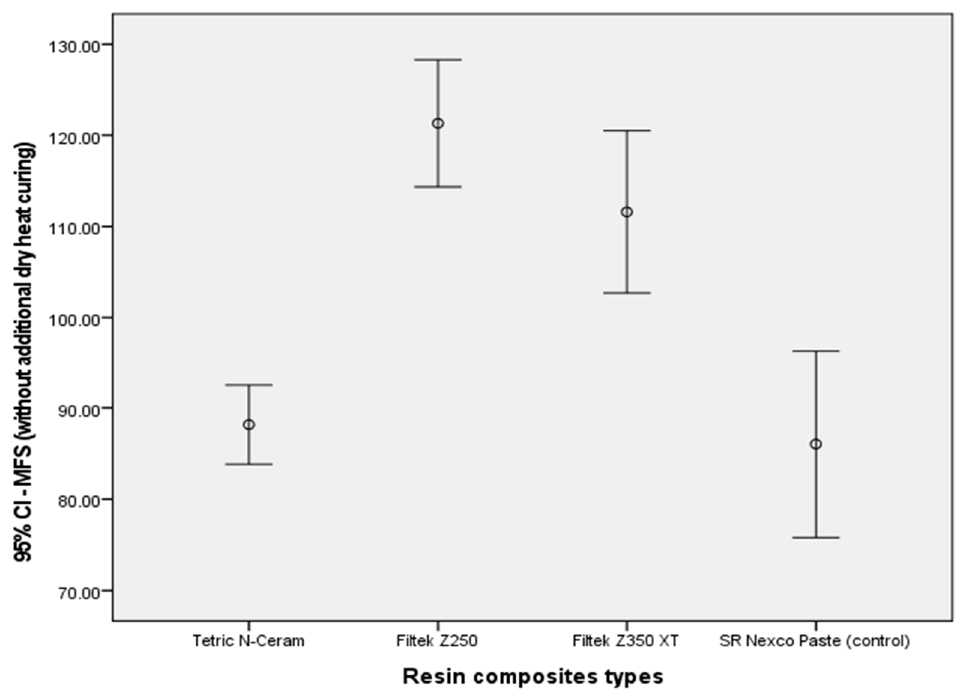
Figure 3. Multiple comparisons of the mean (with a 95% confidence interval) of microflexural strength (MFS) between the resin composite types without additional dry heat curing.